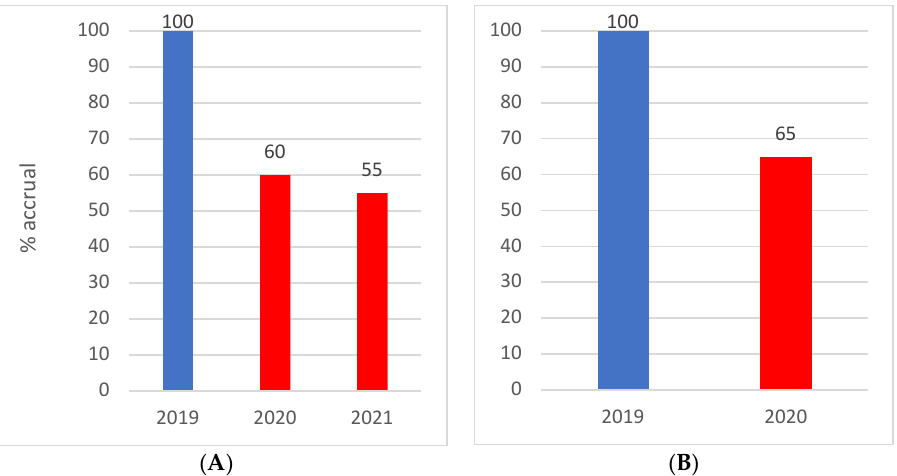
Figure 1. Impact on clinical trial accrual 2019–2021. ( A ) Clinical trial accrual January to June; ( B ) clinical trial accrual January to December.